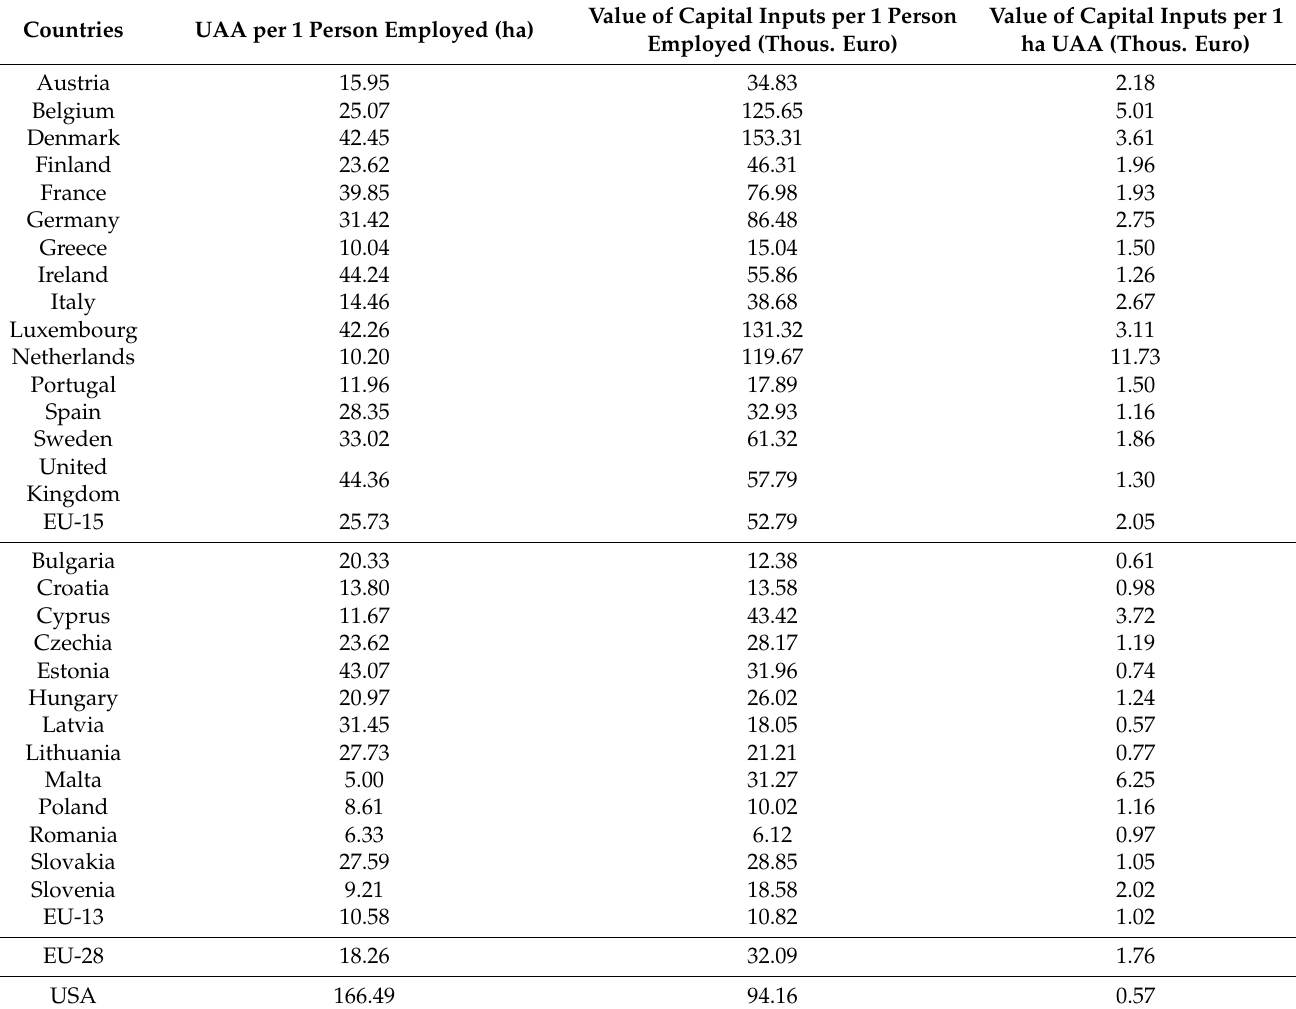
Table 2. Ratios between production factors in the EU and US agriculture in